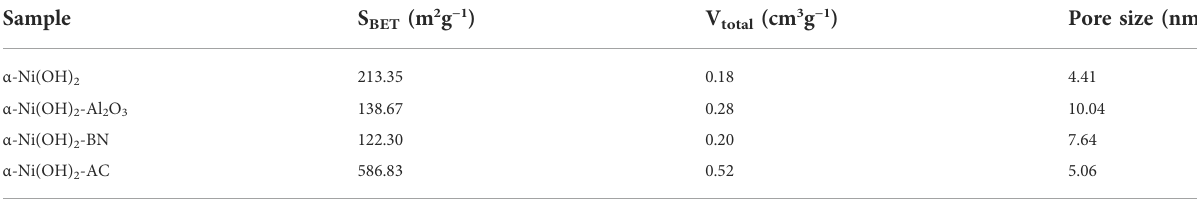
TABLE 2 Structural parameters of different samples.